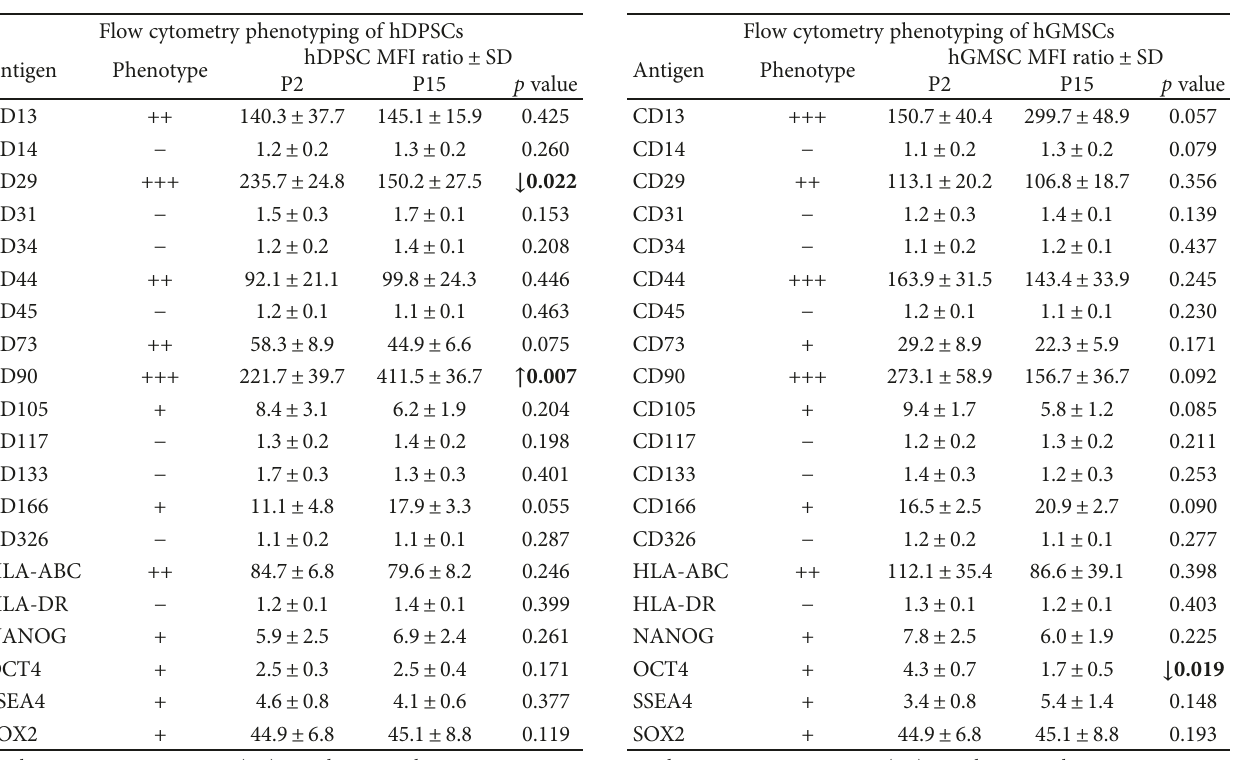
Table 3: Cyto fl uorimetric analysis of